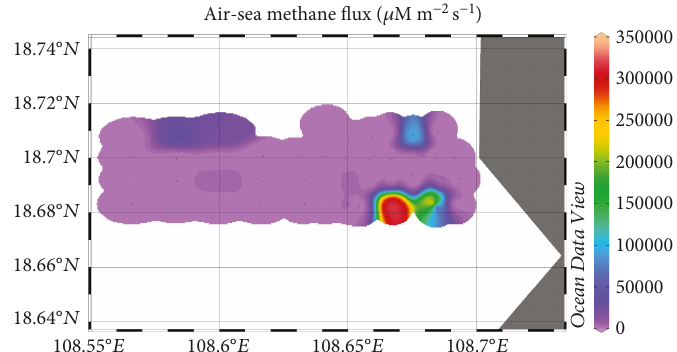
Figure 5: The air-sea fl ux of methane at the Lingtou Promontory seep area. The average wind speed in this area was 5.1m s − 1